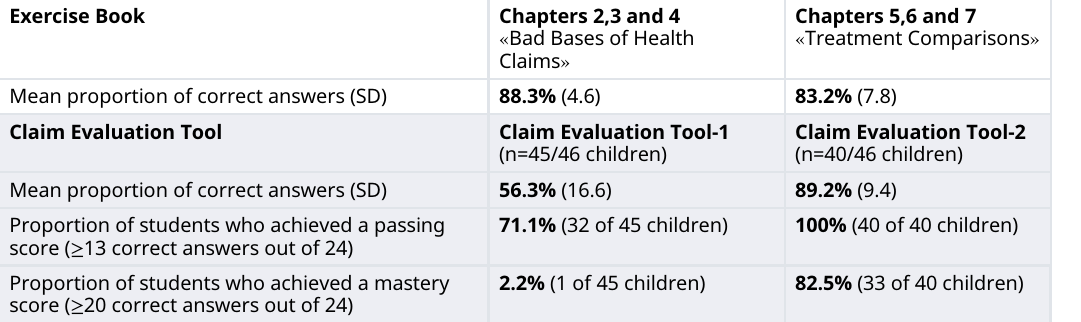
Table 5. Quantitative analysis: Exercise Book and Claim Evaluation Tool. Exercise